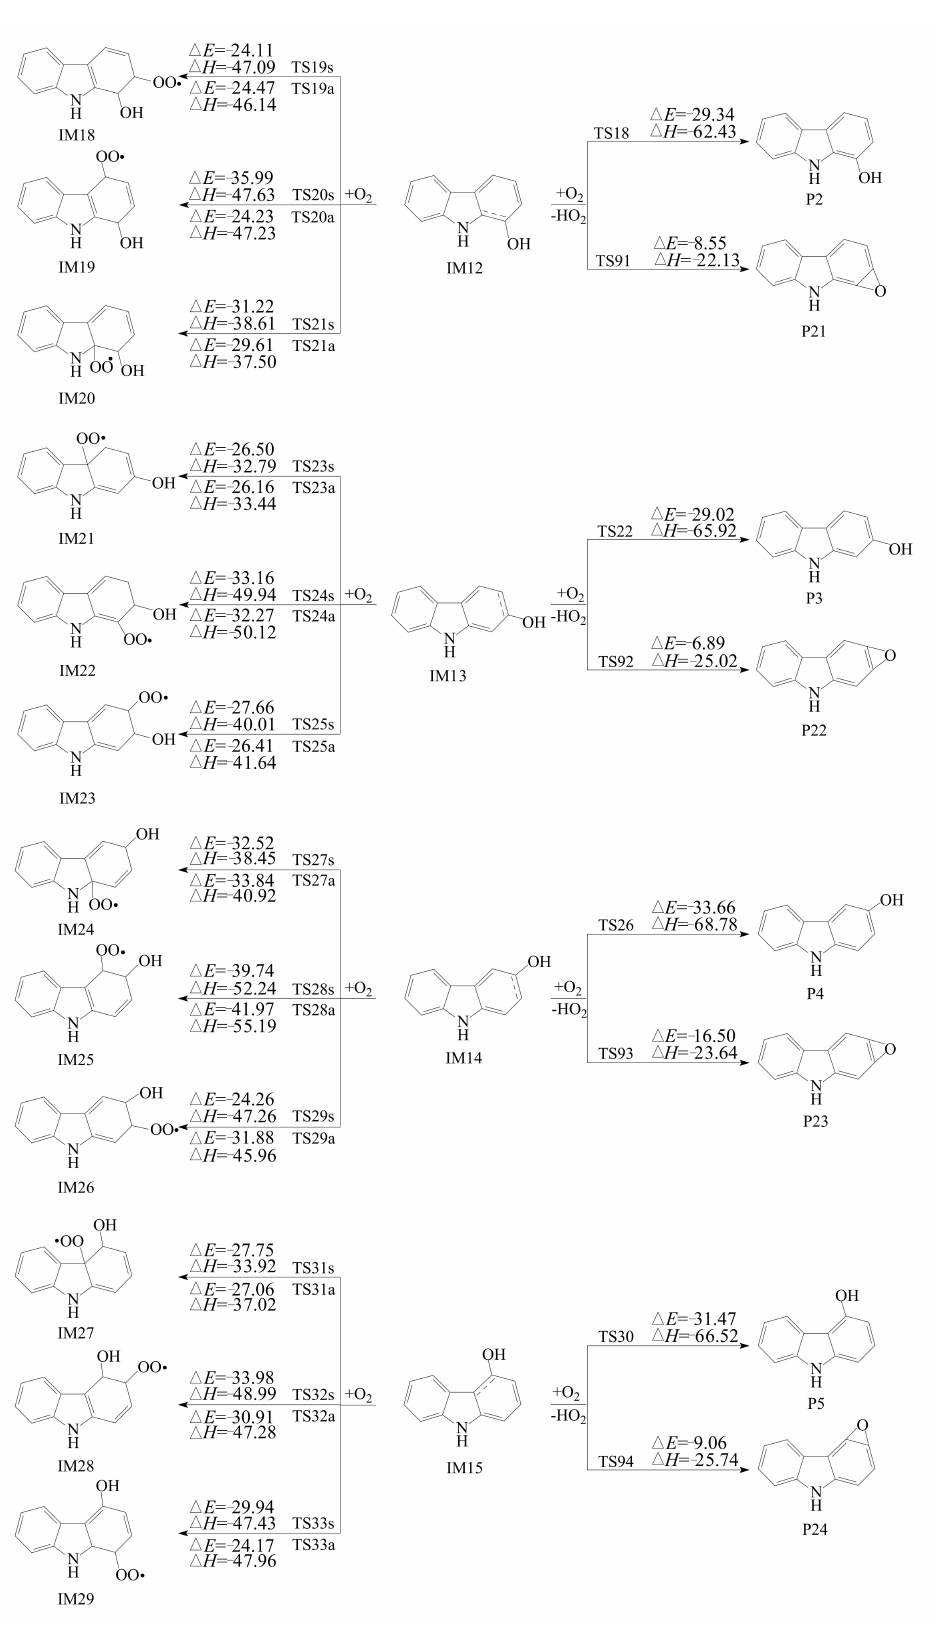
Figure 3. The O 2 addition and abstraction scheme of carbazole-OH adducts embedded with the potential barriers ∆ E (in kcal mol − 1 ) and reaction heats ∆ H (in kcal mol − 1 , 0